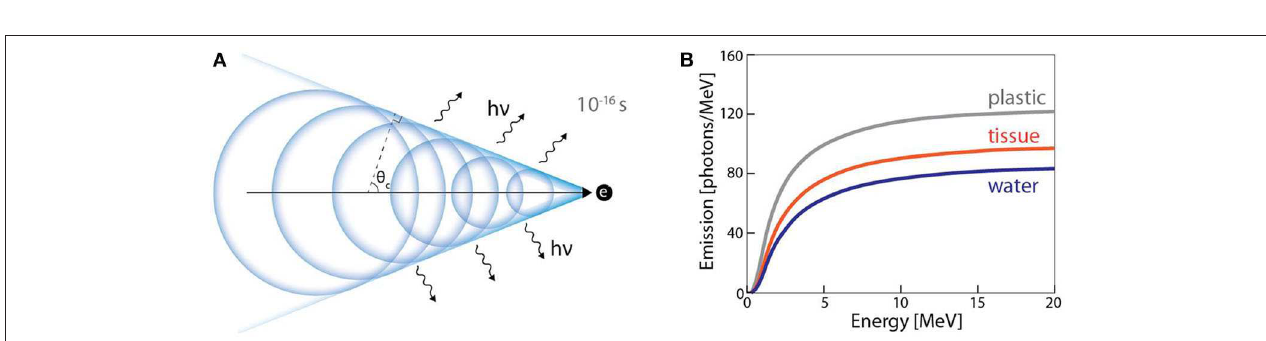
FIGURE 11 | (A) Huygens representation of Cherenkov radiation mechanism in dielectric medium. Light is generated in a cone at caustic angle θ c around the trajectory of charged particle. (B) Energy dependence of Cherenkov radiation for different materials (adapted from Glaser et al. [